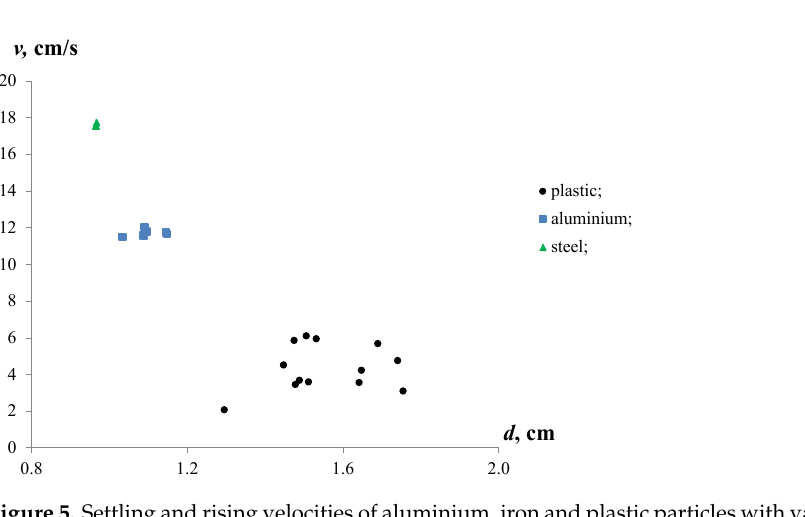
Figure 5. Settling and rising velocities of aluminium, iron and plastic particles with various equivalent diameters in stagnant water.